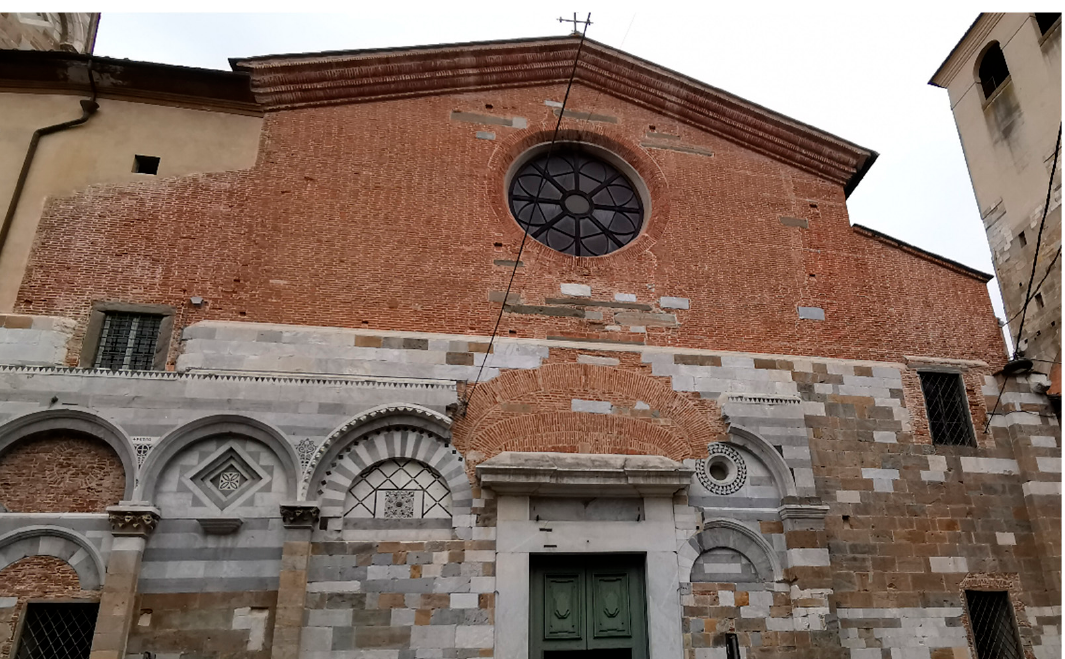
Table 1. Deviations from the vertical line of edges between the façades and the south façade—positive values indicate north − south displacements. Edge Point ID H [m] Deviation [mm] between the main façade and the south façade